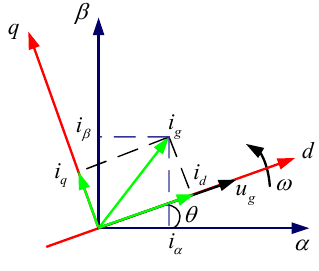
Figure 2. Coordinate reference